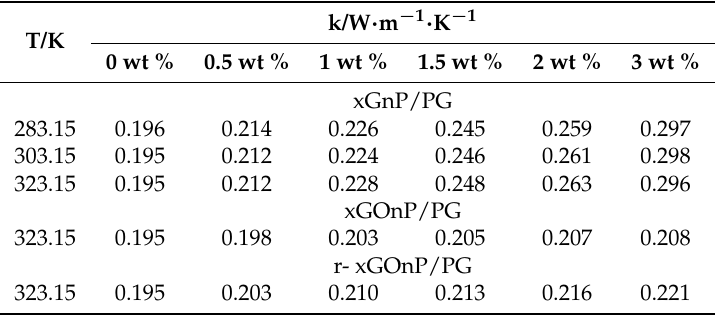
Table 4. Thermal conductivities of xGnP, xGOnP, and r-xGOnP/PG nanofluids at different weight fractions and atmospheric pressures.